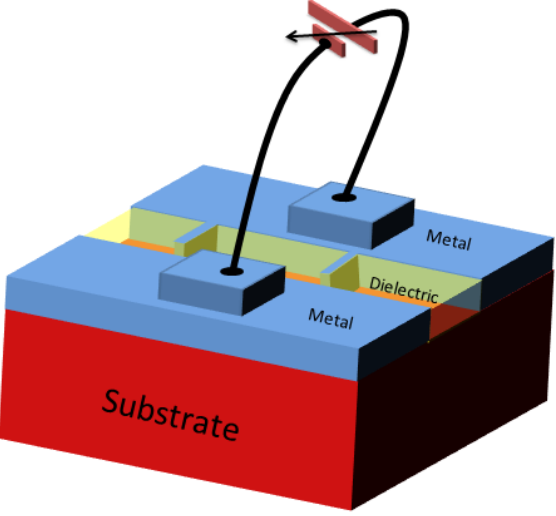
Fig. 7. The relation between the Wavelength and the Cavity length